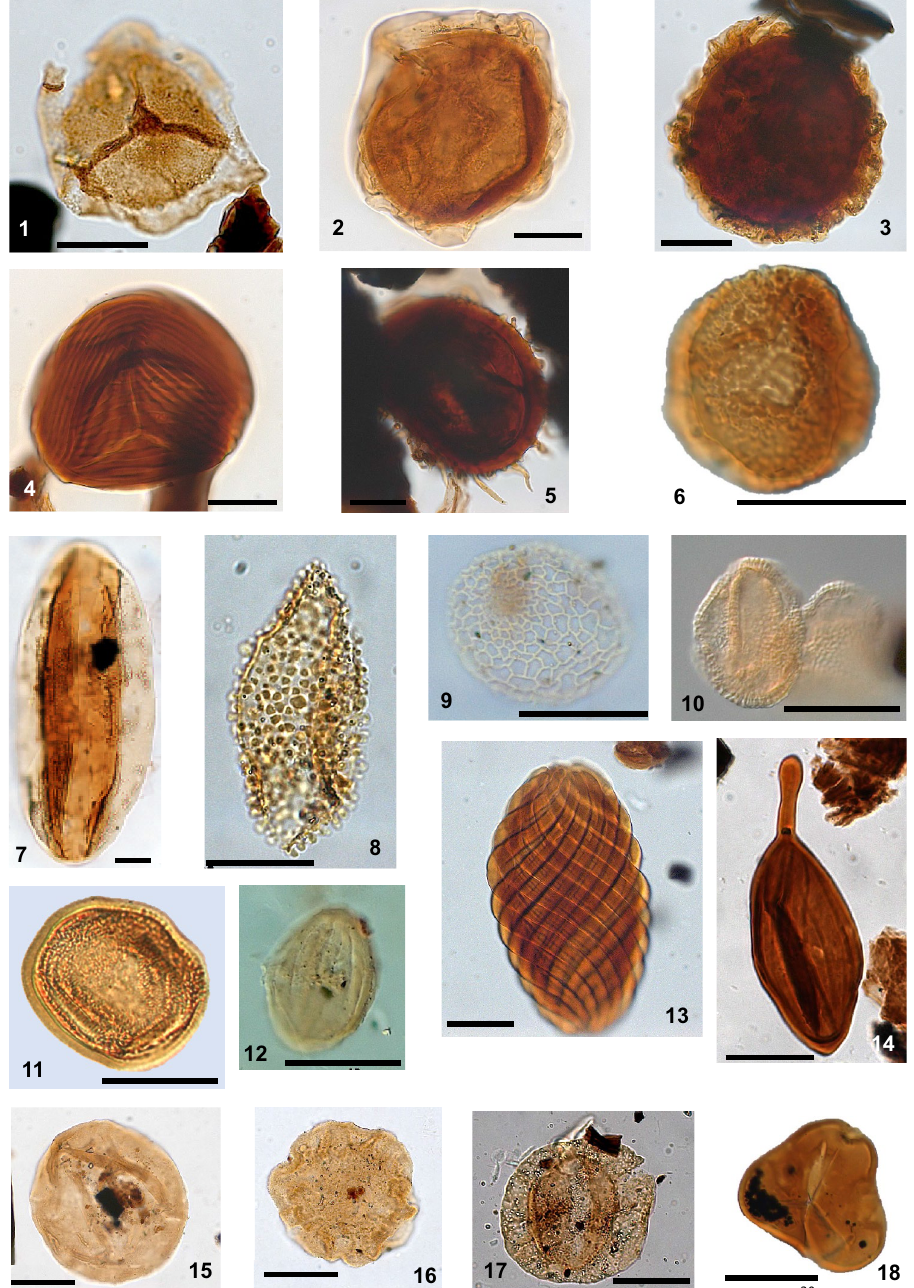
Figure 3. Relevant palynomorphs of bioclimatic groups: (1) Aequitriradites sp.; (2) Crybelosporites sp.; (3) Perotriletes sp.; (4) Cicatricosisporites sp.; (5) Echinatisporis sp.; (6) Verrucosisporites sp.; (7) Bennettitaepollenites sp.; (8) Stellatopollis sp.; (9) Afropollis sp.; (10) Dejaxpollenites microfoveolatus ; (11) Classopollis classoides ; (12) Equisetosporites ovatus ; (13) Gnetaceaepollenites jansonii ; (14) Regalipollenites sp.; (15) Araucariacites sp.; (16) Callialasporites dampieri ; (17) Complicatissacus cearensis ; (18) Cyathidites sp.. Scale bar 20